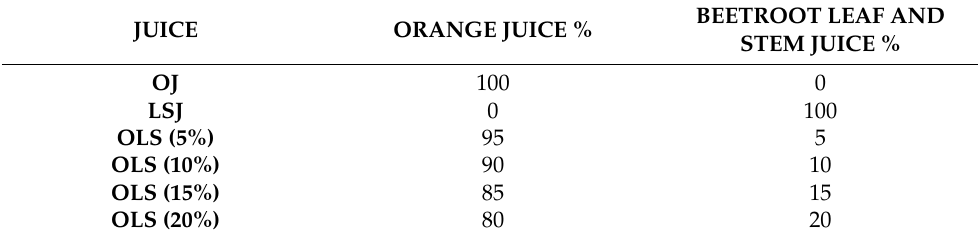
Table 1. The blends of orange juice and beetroot leaf and stem juice.